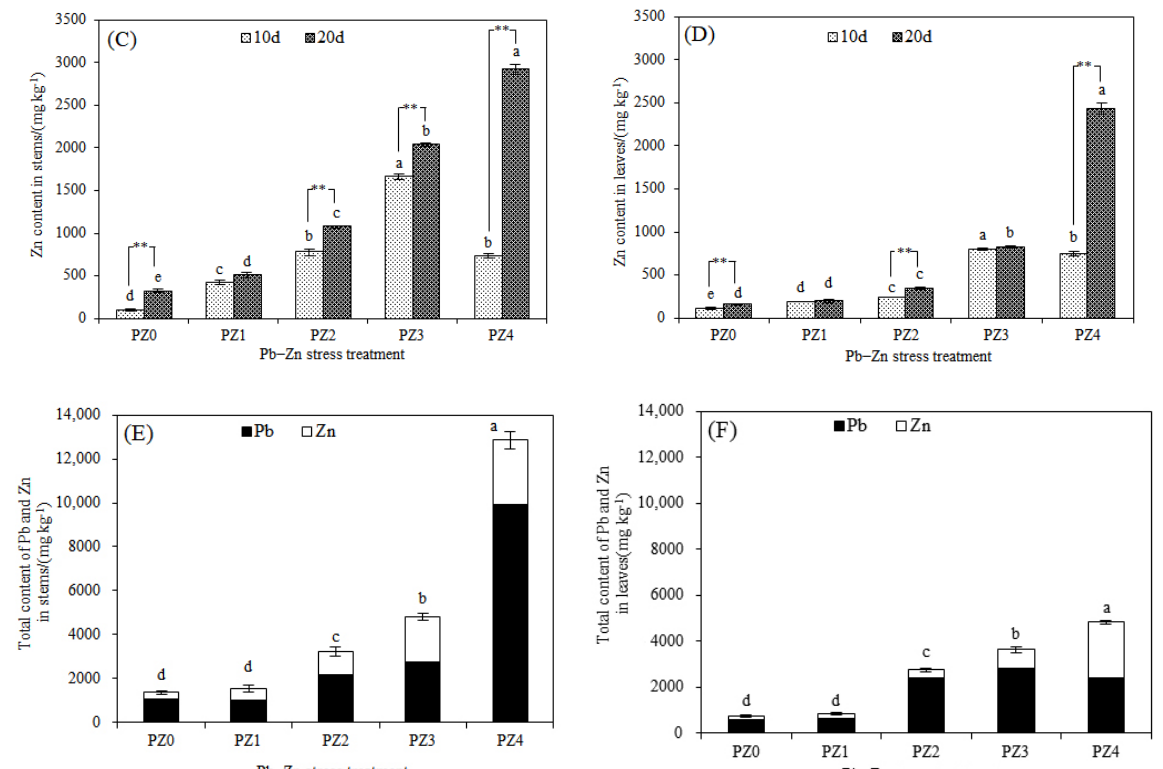
Figure 5. Impacts of different treatment times and Pb–Zn treatments on Pb content in stems ( A ), Pb content in leaves ( B ), Zn content in stems ( C ), Zn content in leaves ( D ), the total content of Pb and Zn in stems after 20 days of treatment ( E ) and total content of Pb and Zn in leaves after 20 days of treatment ( F ). Along the x -axis of each graph, PZ0, PZ1, PZ2, PZ3 and PZ4 indicate that the Pb concentration is 300 mg/L and that the Zn concentrations are 0, 75, 150, 300, and 600 mg/L, respectively. Vertical bars represent the standard errors of the mean ( n = 3). Different letters indicate significant differences among treatments with different Zn concentrations under the same treatment time ( p < 0.05). ** indicates an extremely significant difference at 0.01 under the same treatment and different time ( p < 0.01).